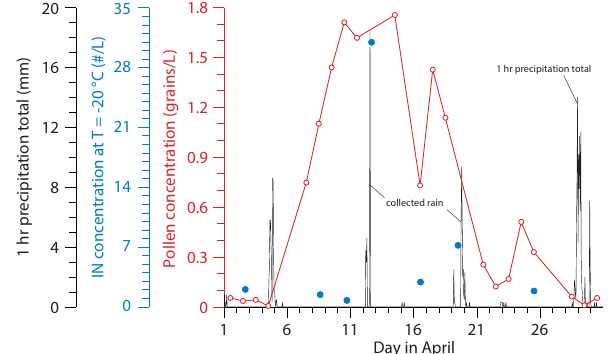
Figure 7. Hourly precipitation (black line), 24h pollen grain con- centrations (open red circles), and derived IN concentrations at T =− 20 ◦ C (filled blue circles) for the month of April 2013.